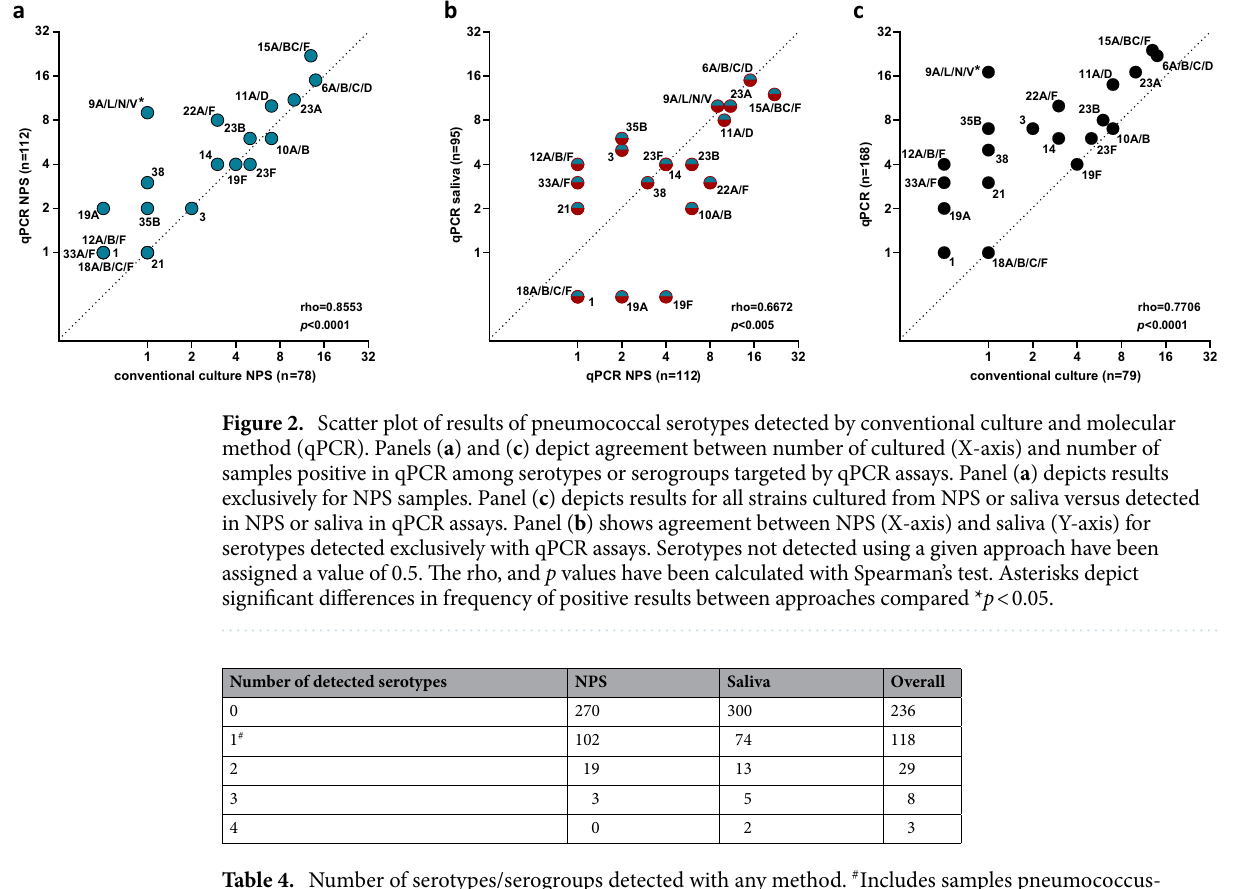
the number of serotype carriers detected with qPCR in NPS’s and in saliva (Spearman’s rho = 0.667, p < 0.01) (Fig. 2b), as well as between the numbers of serotype-carriers detected with qPCR in NPS’s or in saliva versus overall cultured in the study (Spearman’s rho = 0.771, p < 0.0001) (Fig. 2c). Although the absolute number of VT isolates cultured from children attending DCC was significantly higher (n = 17 isolates cultured from 207 DCC attendees vs. n = 6 isolates cultured from 187 children staying home, p = 0.051) and in fractions of VT isolates among all n = 71 cultured from DCC attendees compared with fractions among all n = 28 cultured from children staying home (17/71 or 24.0% vs. 6/28 or 21.4% for PCV10-VTs, p = 1; and 20/71 or 28.2% vs. 6/28 or 21.4% for PCV13-VTs, p = 0.62). Although the DCC attendees were more likely to be carriers, the serotype distribution was not different between children attending DCC and staying home. None of the other demographic or environmental factors were associated with differences in serotype carriage. Co‑carriage of multiple serotypes. The presence of two or more serotypes was detected in 40 (25.3%) of 158 children identified as carriers by either culture or using piaB and lytA qPCRs (Table 4). Co-carriage of two or more serotypes/serogroups was detected in 17.7% (22 of 124) NPS’s and 25.5% (20 of 94) saliva samples classified as positive for S. pneumoniae by any method. There was no significant difference in the prevalence of co-carriage in NPS’s and saliva samples ( p = 0.60). Also, there were no statistically significant differences in co- carriage according to age (12–23 months old, 17 of 62; 24–35 months old, 6 of 36; 36–47 months old 12 of 30; 48–59 months old, 5 of 30; p > 0.05 between any two age groups), DCC attendance (‘yes’ 32 of 109 vs. ‘no’ 8 of